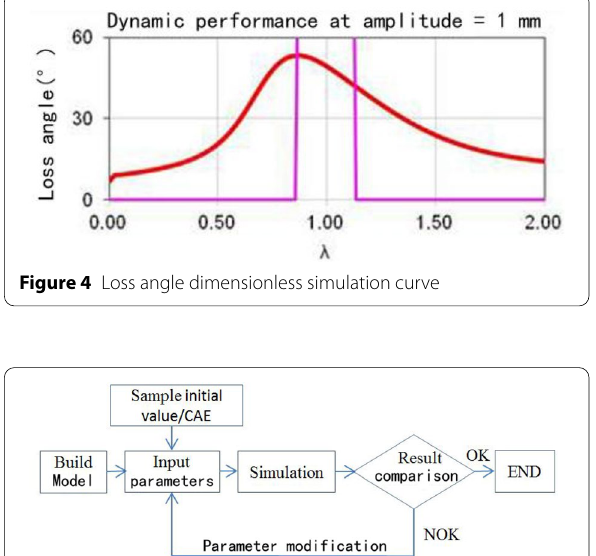
Figure 5 Parameter acquisition process